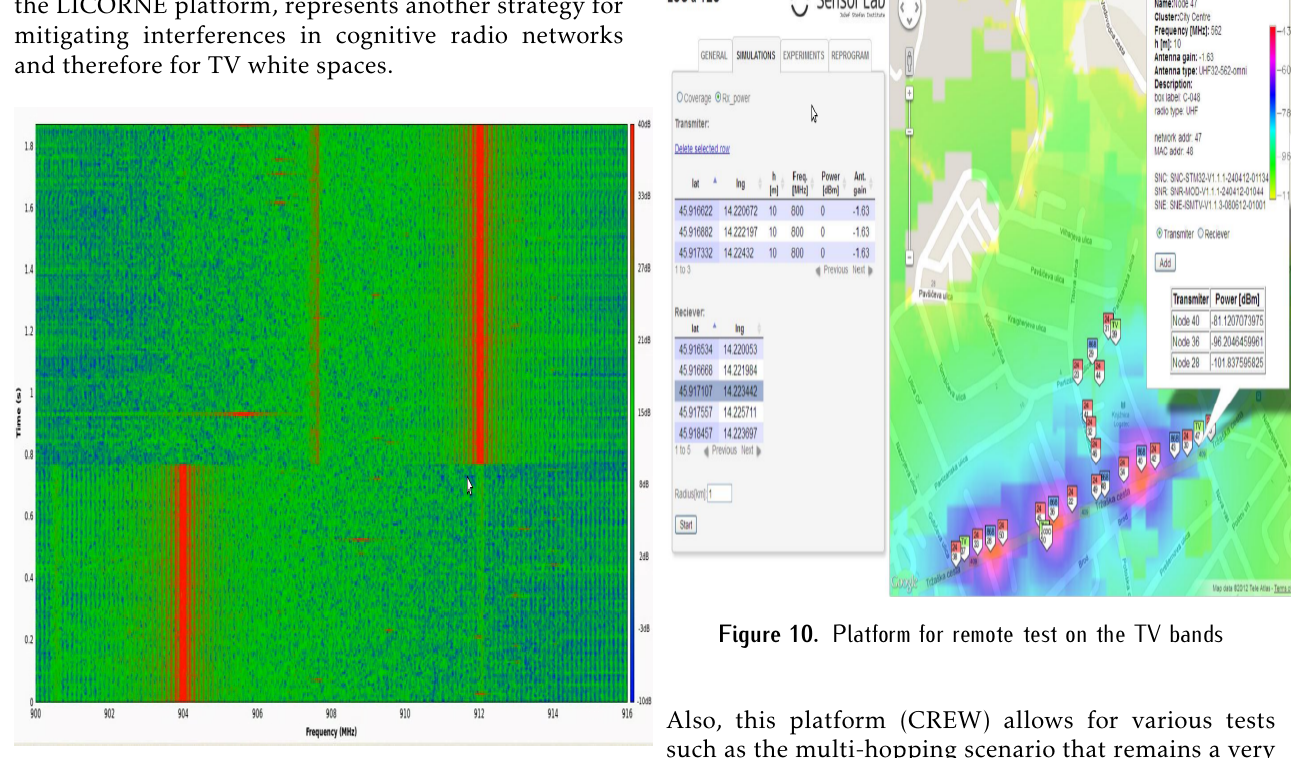
Figure 9. Frequency hopping for interferences avoidance